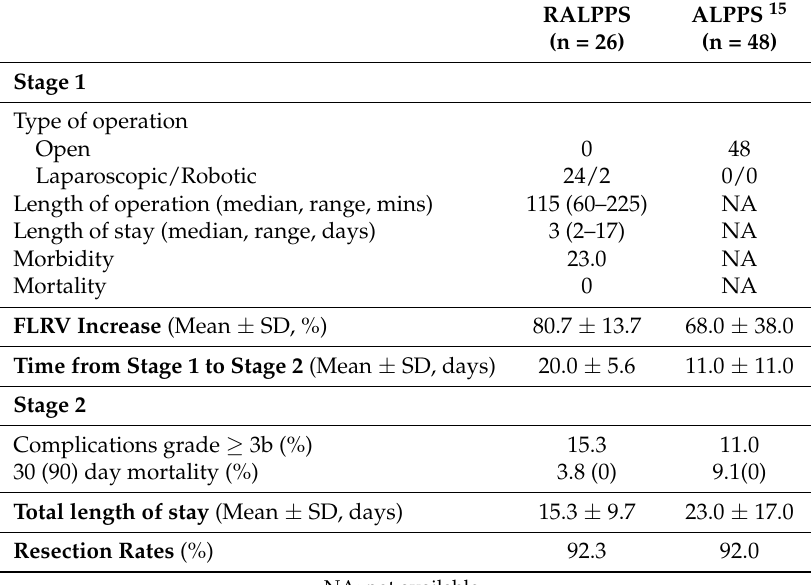
Table 4. Comparison of two randomised control trials: RALPPS versus ALPPS